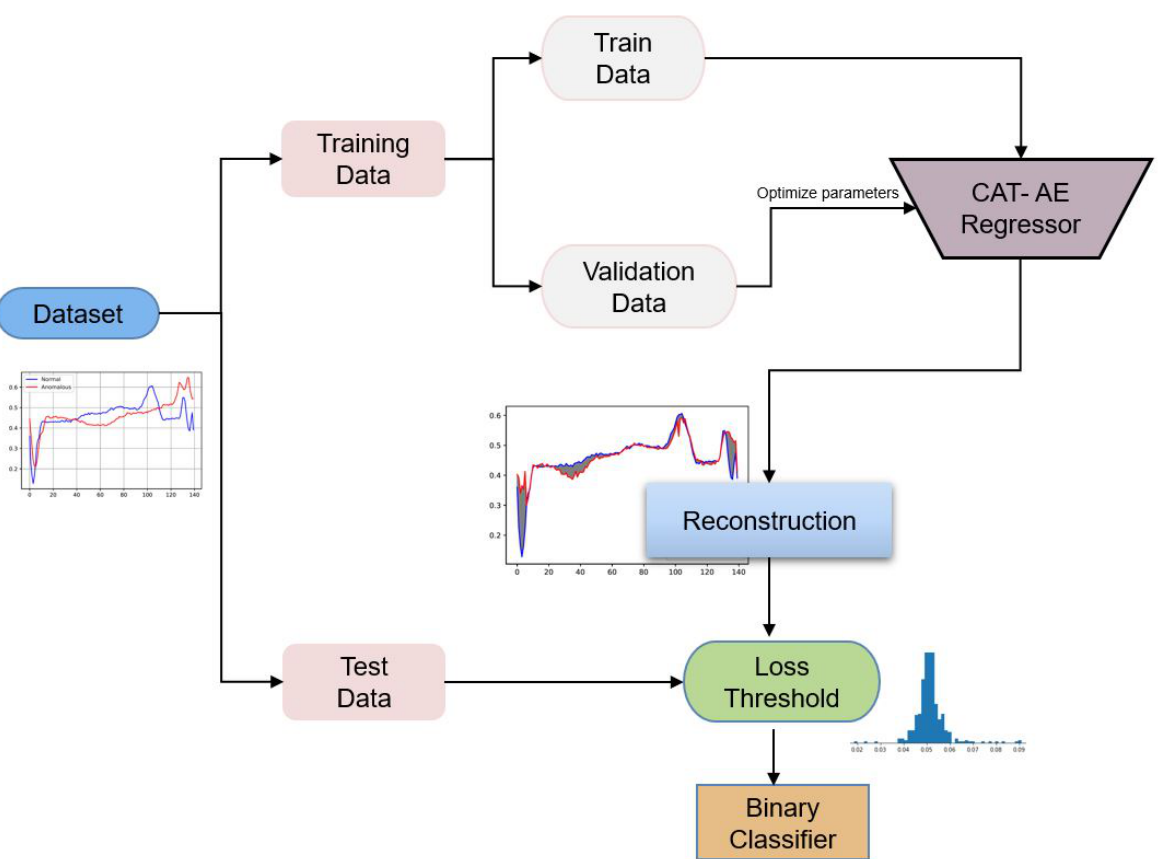
Figure 4. Architectural procedure for training the autoencoder model.